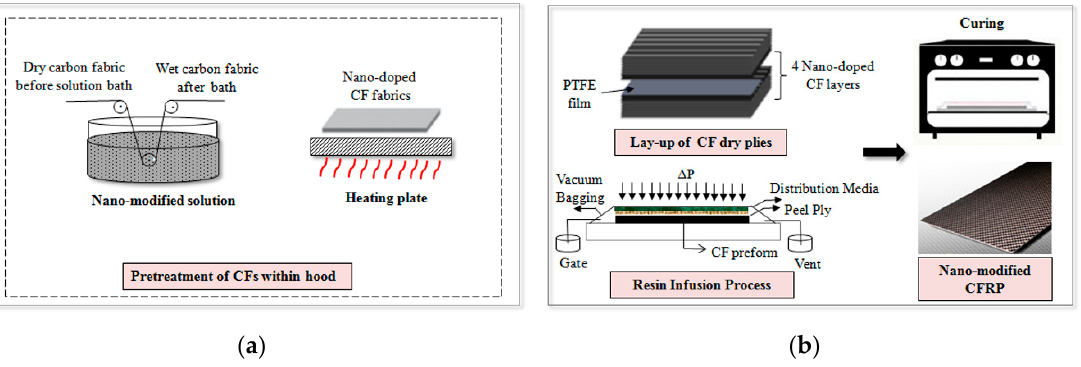
Figure 1. The step by step manufacturing process of nano-modified carbon fibre reinforced polymer (CFRP) laminates. ( a ) The pre-treatment of dry carbon fabrics to produce nano-modified reinforcement, ( b ) The production of CFRP laminates using infusion process (VARTM).